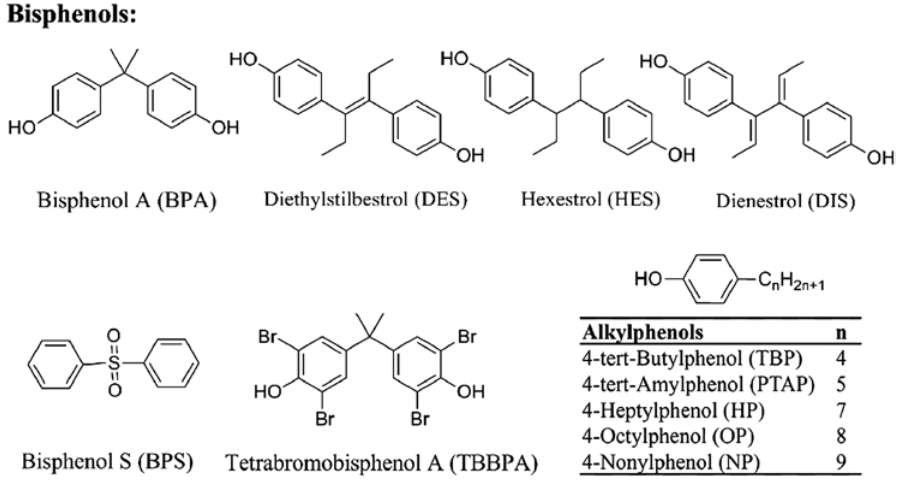
Figure 1: Structures of the main PEEs considered for this